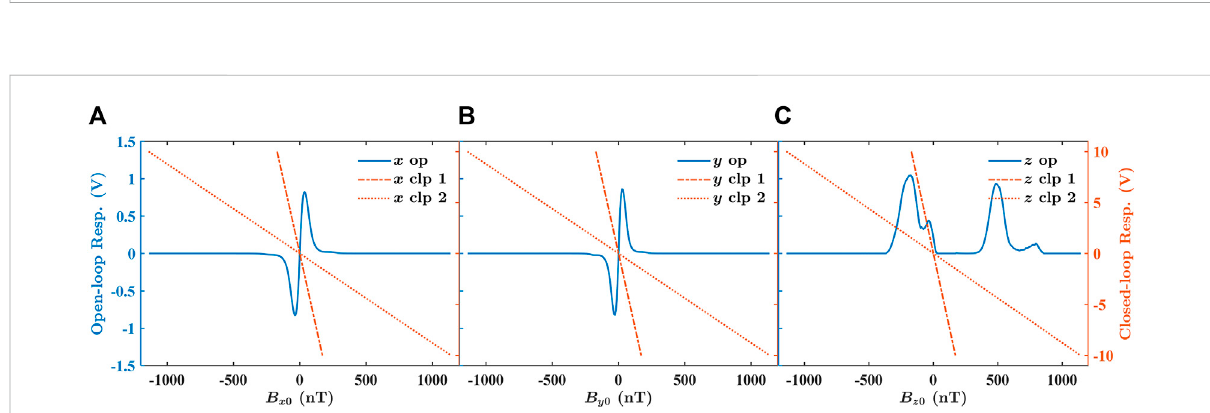
FIGURE 7 The amplitude-frequency response of the triaxial magnetometer to magnetic fi eld detected along x -axis (A) , y -axis (B) and z -axis (C) , when the magnetometer is operating with open-loop parameters consistent with the simulation in Section 2.1 ( “ open-loop 1 ” ), open-loop high-frequency measurement parameters ( “ open-loop 2 ” ), or closed-loop control. “ Normalized Amp. ” is the abbreviation for normalized amplitude, with low- frequency triaxial fi eld gains regarded as unit.